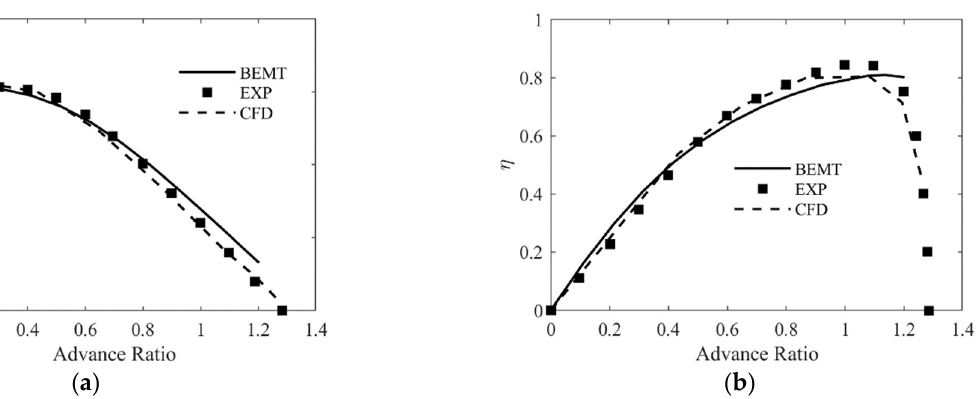
Figure 10. Thrust and efficiency comparisons between the BEMT, CFD and wind tunnel experiments for the 3-blade NACA 5868-9 propeller. ( a ) Thrust coefficients; ( b ) efficiency.